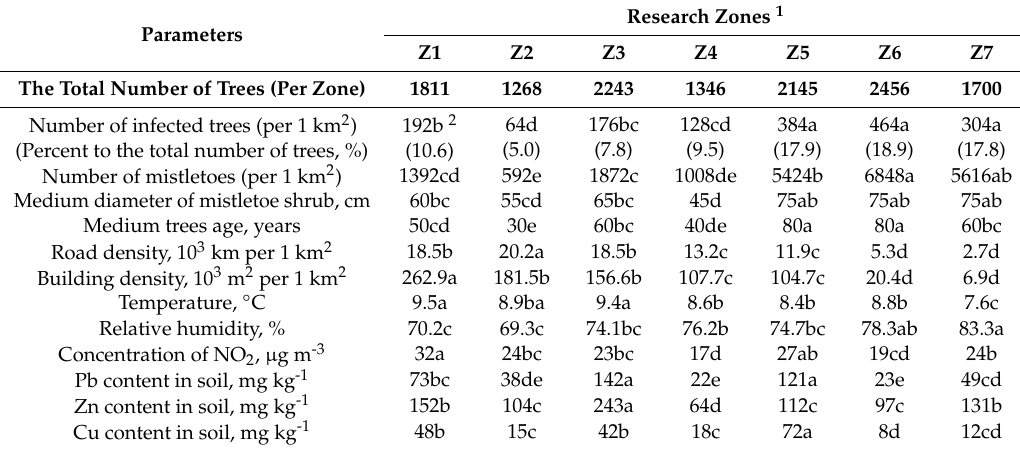
Table 3. The occurrence of mistletoe infestation and landscape, ecological, and microclimatic features of research zones.